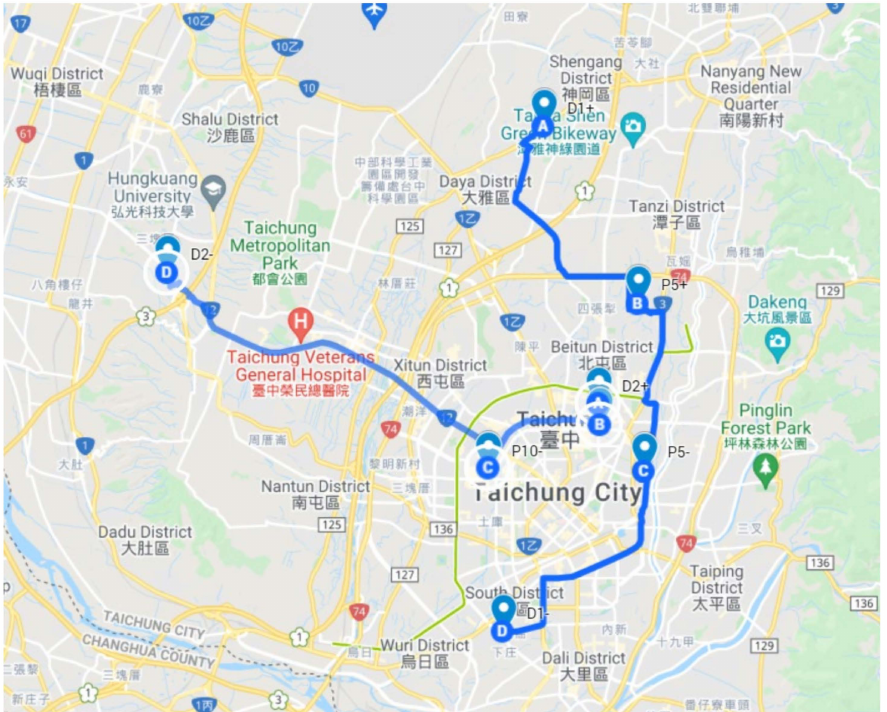
Figure 1. Two shared routes for Case 1 of the Example.